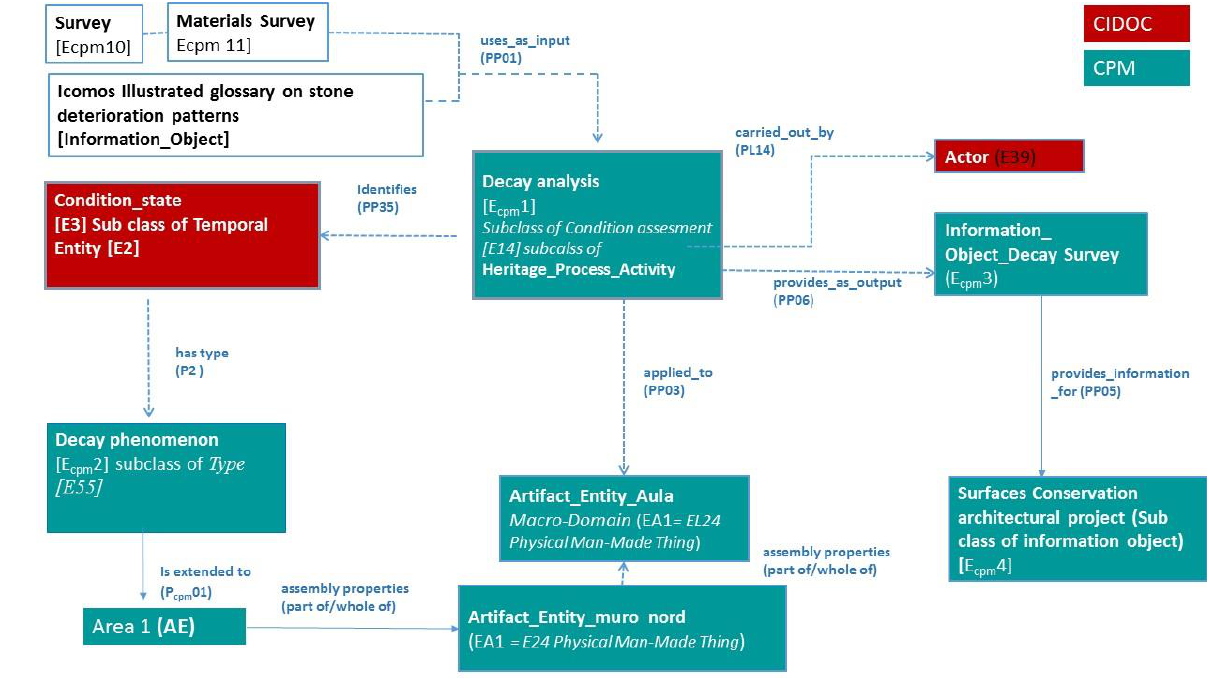
Figure 3. Decay analysis